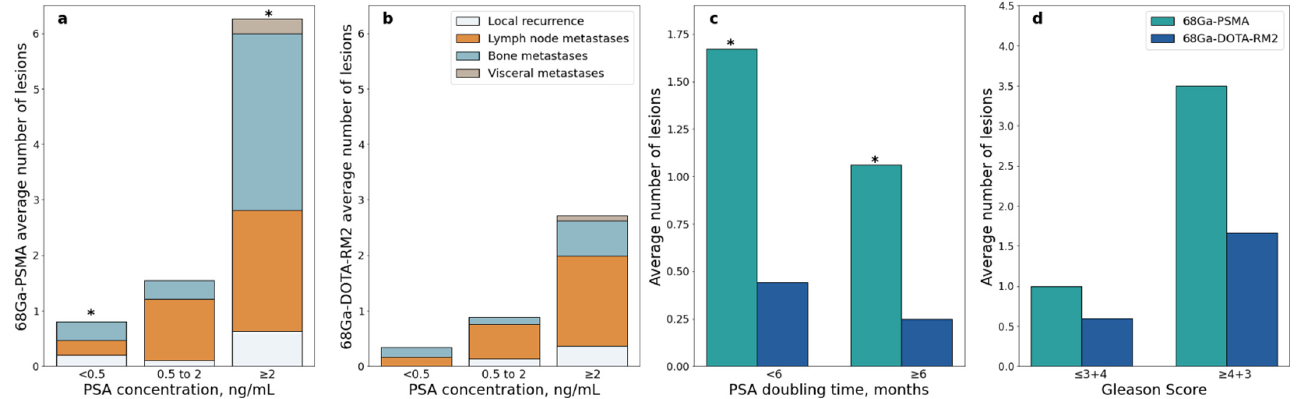
Figure 7. 68 Ga-PSMA and 68 Ga-DOTA-RM2 PET/MRI detection rates stratified according to clinical data; ( a ): Average number of 68 Ga-PSMA PET/MRI positive lesions stratified by site and PSA level at time of scans; ( b ): Average number of 68 Ga-DOTA-RM2 PET/MRI positive lesions stratified by site and PSA level at time of scans; ( c ): Average number of 68 Ga-PSMA and 68 Ga-DOTA-RM2 PET/MRI positive lesions stratified by PSA doubling time; ( d ): Average number of 68 Ga-PSMA and 68 Ga-DOTA-RM2 PET/MRI positive lesions stratified by Gleason Score, * = p < 0.05. Similarly, higher PSA serum levels were associated with more PET positive lesions in 68 Ga-DOTA-RM2 PET/MRI, but significance was lost after correction for multiple testing (Mann-Whitney U = 46, adjusted p = 0.17; Figure 7b). The number of PET positive lesions did not differ significantly across GS levels both on 68 Ga-PSMA and 68 Ga-DOTA-RM2 PET/MRI (Mann-Whitney U = 56, adjusted p = 0.43 and U = 66.5, adjusted p =